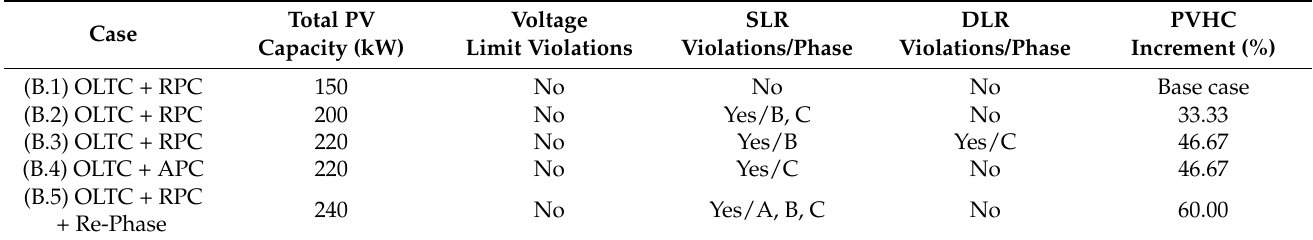
Table 2. Summary of the case